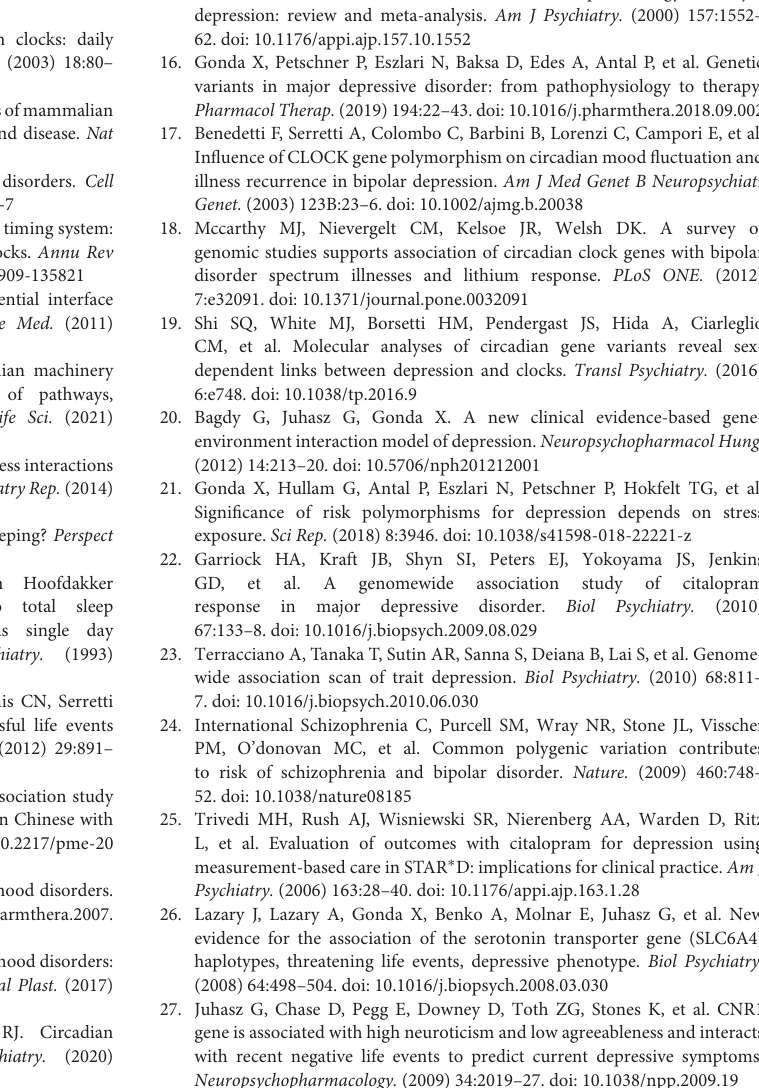
control steps are shown. SNPs in significant clumps are marked in red, top SNP of the clump is marked in bold red. Results for additive, dominant, and recessive models are shown. regression models are shown. There were no nominally significant SNPs, significant clumps could not be identified. Supplementary Table 7 | In silico characterization and functional prediction of SNPs in the clumps significantly interacting with recent life events (RLE) and childhood adversities (CHA). Top SNP of each clump is marked in bold